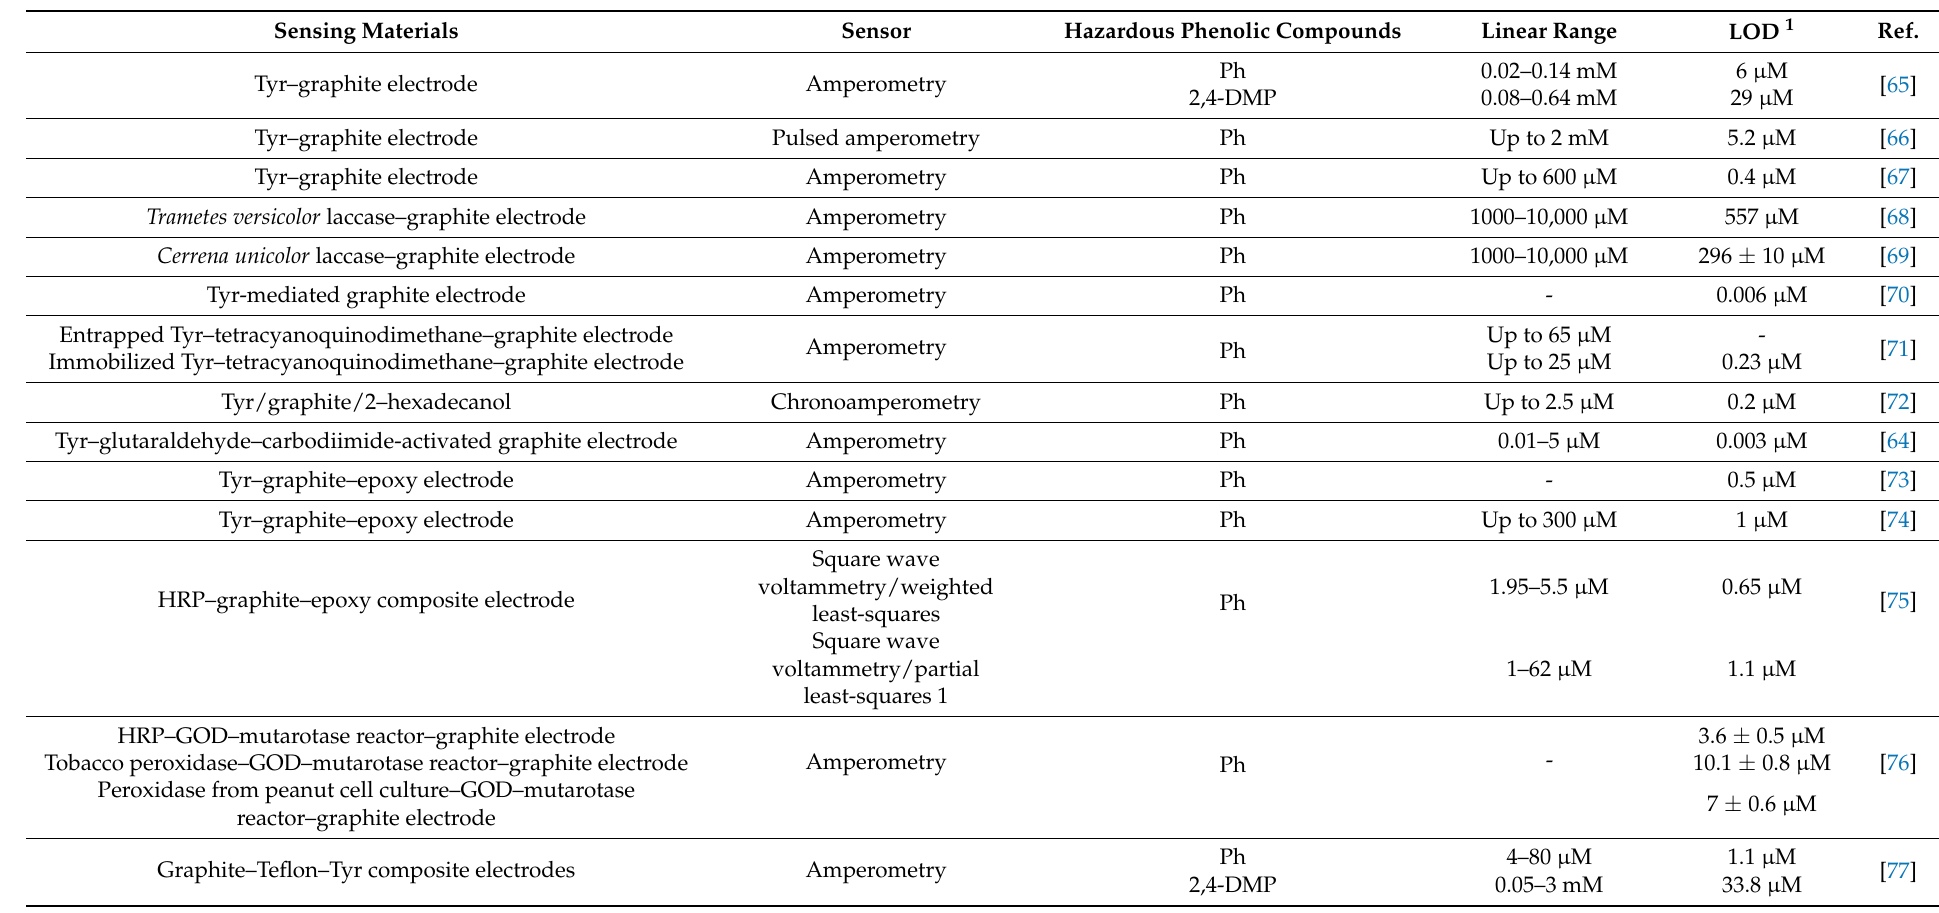
Table 1. Graphite-based materials incorporated with electrochemical sensors for hazardous phenolic compounds